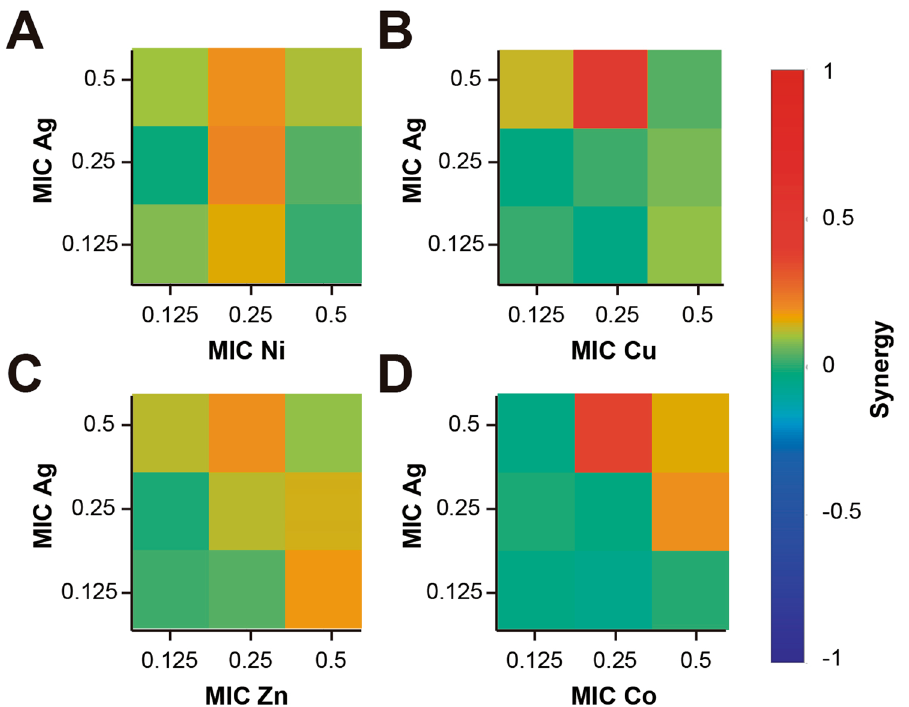
Figure 4. Analysis of Ag-Transition Metal Interactions. Classification of the different interaction between Ag- transition metal in Bacillus subtilis ATCC 23857. The interactions of Ag with ( A ) Ni, ( B ) Cu, ( C ) Zn and ( D ) Co, are classified as synergistic, additive or antagonistic, value > 0, = 0 and < 0, respectively. Each checkerboard treatment was done in